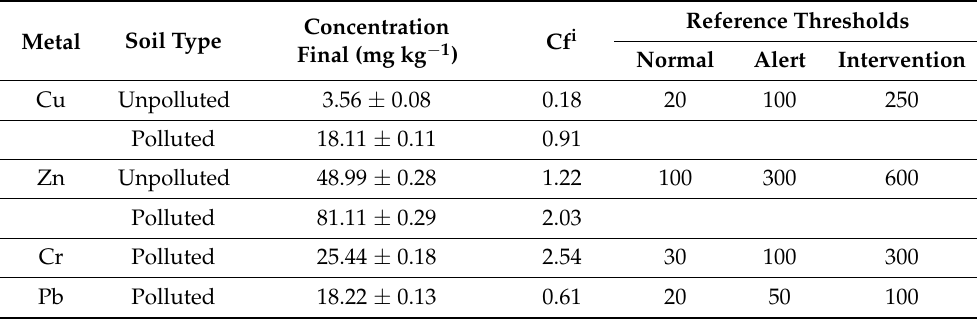
Table 14. Final mean concentration of heavy metals in soil and reference thresholds (according to Order 756/1997, Environmental Pollution Assessment